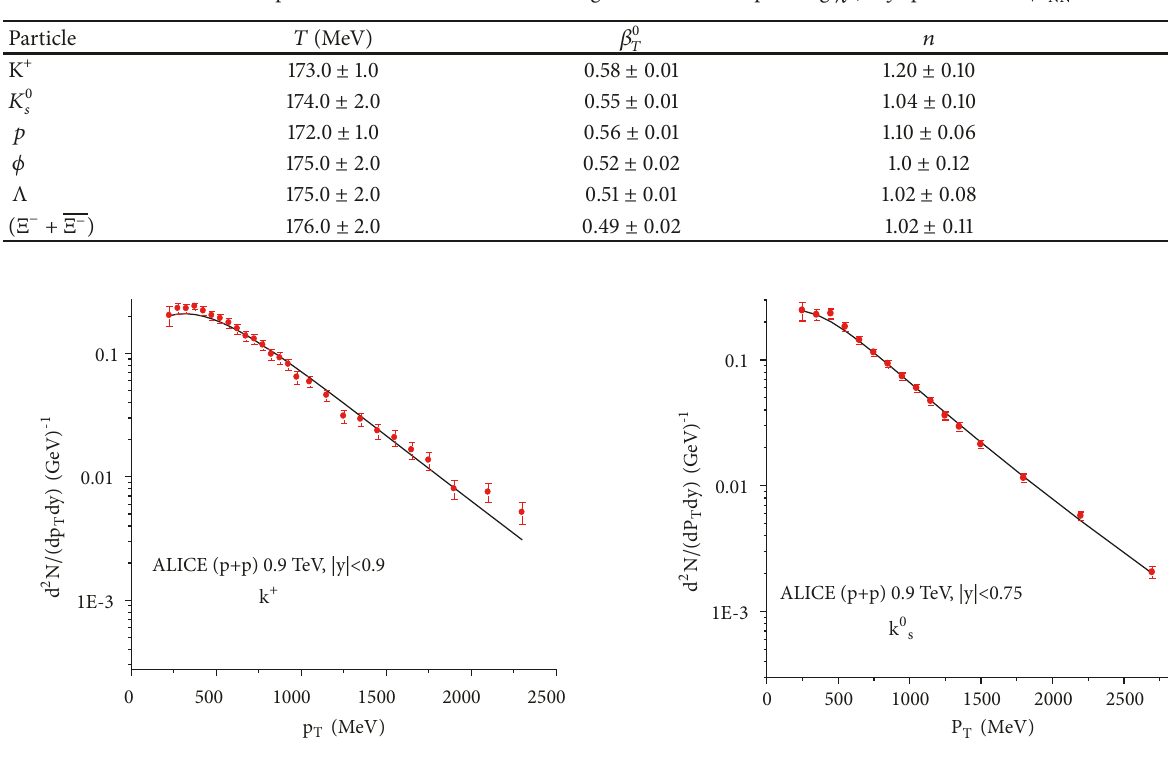
Figure 3: Transverse momentum spectrum of K + .